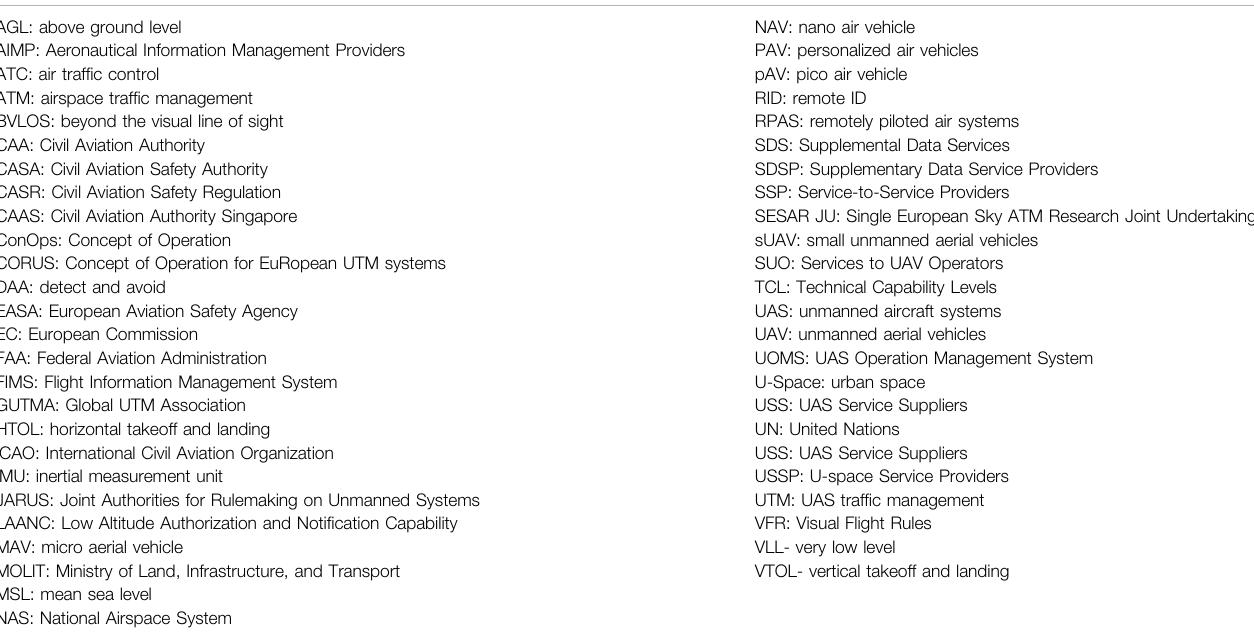
TABLE 1 | List of acronyms. AGL: above ground